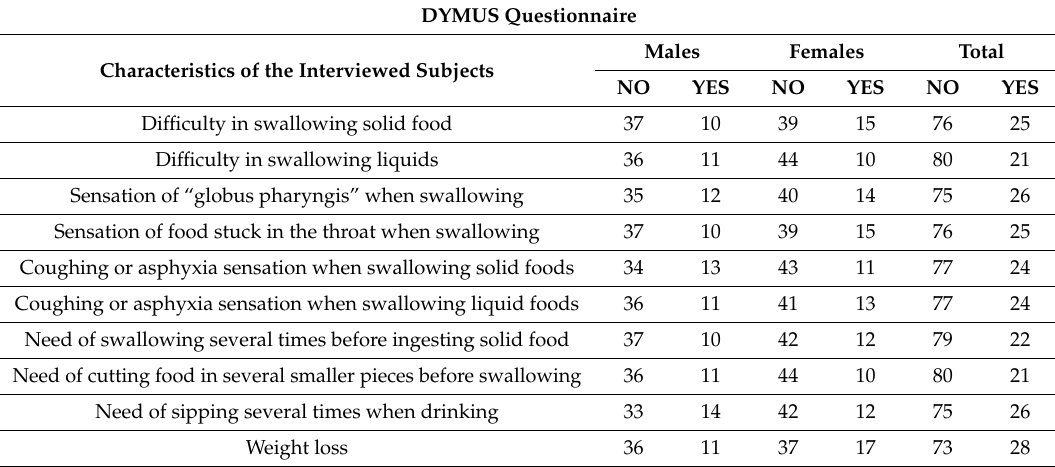
Table 2. DYMUS Questionnaire Results (DYsphagia in MUltiple